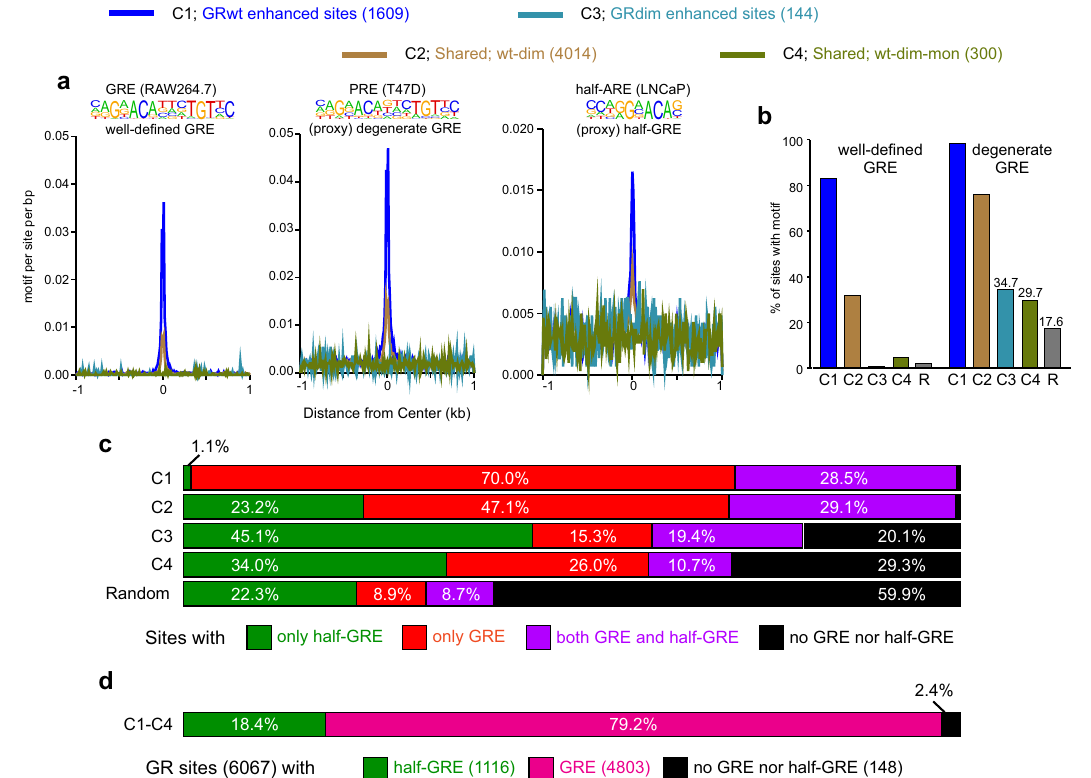
Fig. 4 Pre-de fi ned motif analyses. a Motif enrichment of a well-de fi ned GRE (HOMER motif gre-raw.motif), a proxy for a more degenerate GRE (HOMER motif pr.motif) and a proxy for a half-GRE (HOMER motif ar-half.motif) at GR ChIP peaks from each cluster (C1 – C4). Position-weight matrix (PWM) logo for each GRE shown above each aggregate plot. All aggregate plots normalized to 10 million reads, and to motif per site per bp. b The percentage of sites within each cluster (C) that contain each pre-de fi ned motif as well as the percentage at 2000 randomly chosen (R) ATAC peaks from the Dex-treated GRwt cell line. c The percentage of GR peaks with only a full GRE (red color), only a half-GRE (green color), both a full GRE and half-GRE (purple color), or no GRE nor half-GRE (black color). The degenerate full GRE and half-GRE in a were used to determine the percentages. d The percentage of all GR peaks (6067) that contain half-GRE (green), full GRE (magenta) or no half nor full GRE (black). Source data are provided as a Source Data fi